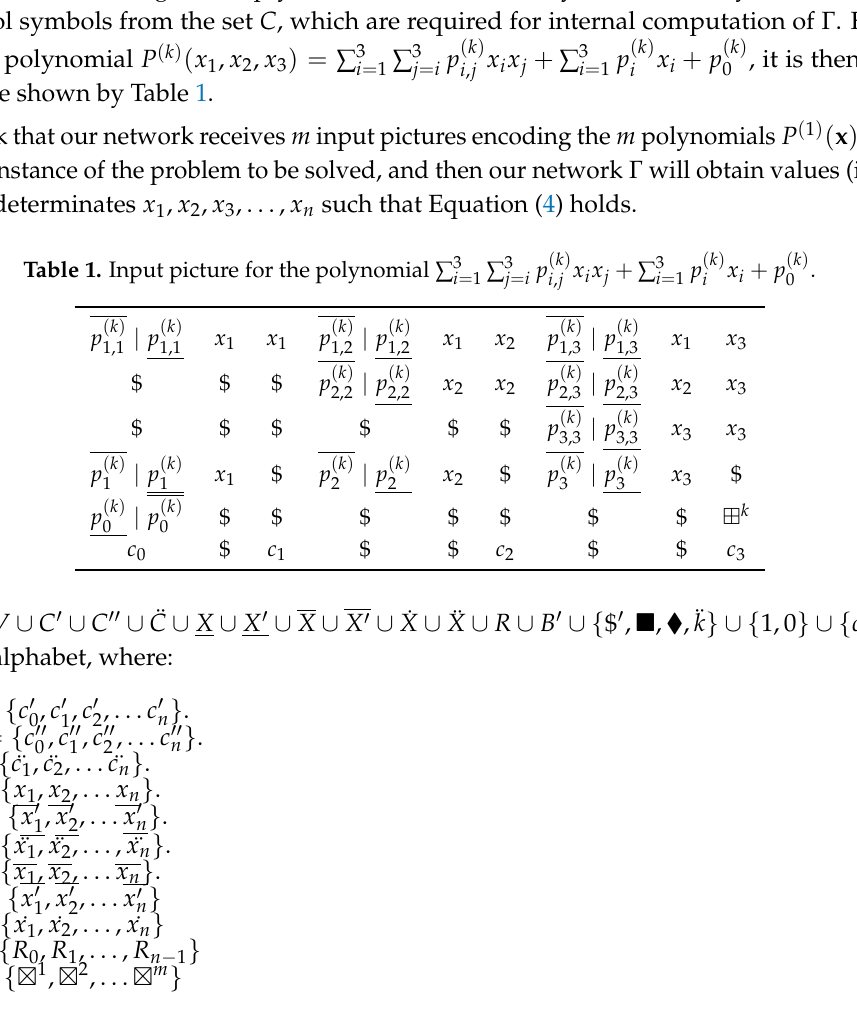
Table 1. Input picture for the polynomial ∑ 3